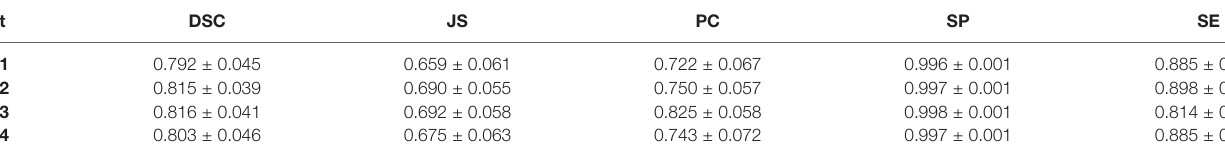
TABLE 1 | Experiments indicate that our model achieves the best performance when t = 3.